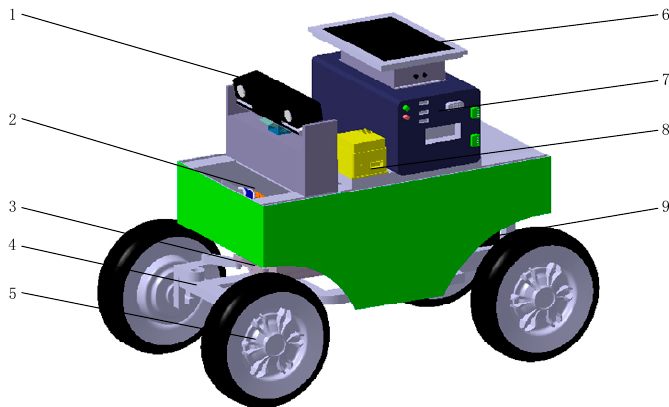
Figure 1. Structure diagram of field information collection robot: 1. Kinect camera; 2. Damping spring; 3. Stepper motor; 4. Steering mechanism; 5. Hub motor; 6. Host computer; 7. Industrial personal computer; 8. Inertial navigation; 9. Lithium battery